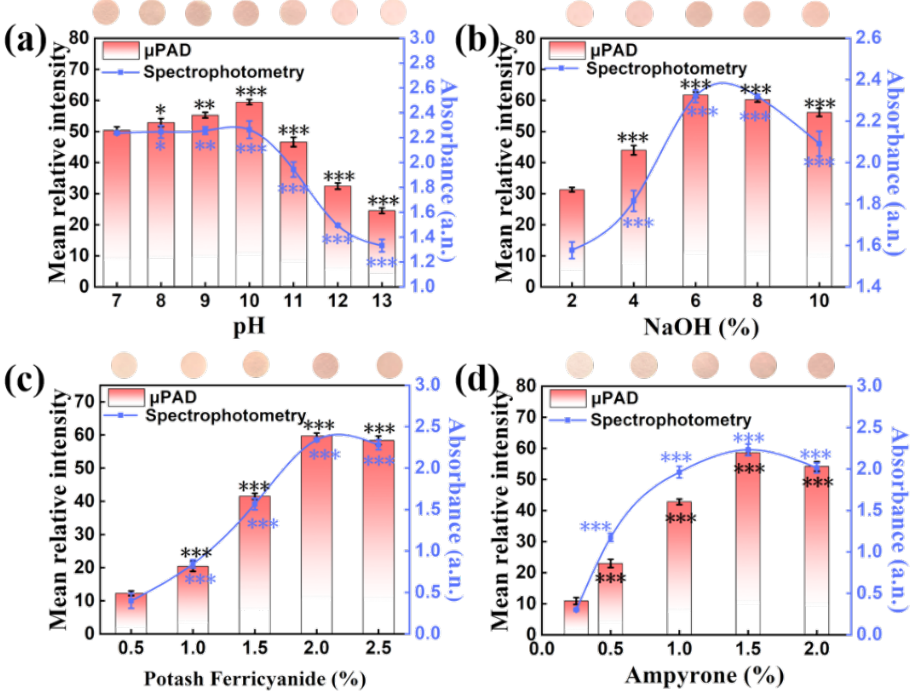
Figure 8. The effects of experimental conditions on pSBMA-μPAD and spectrophotometry: ( a ) the concentration of NaOH, ( b ) pH of system buffer, ( c ) the concentration of potassium ferricyanide and ( d ) the concentration of 4-aminoantipyrine. “*” stands for significance test.